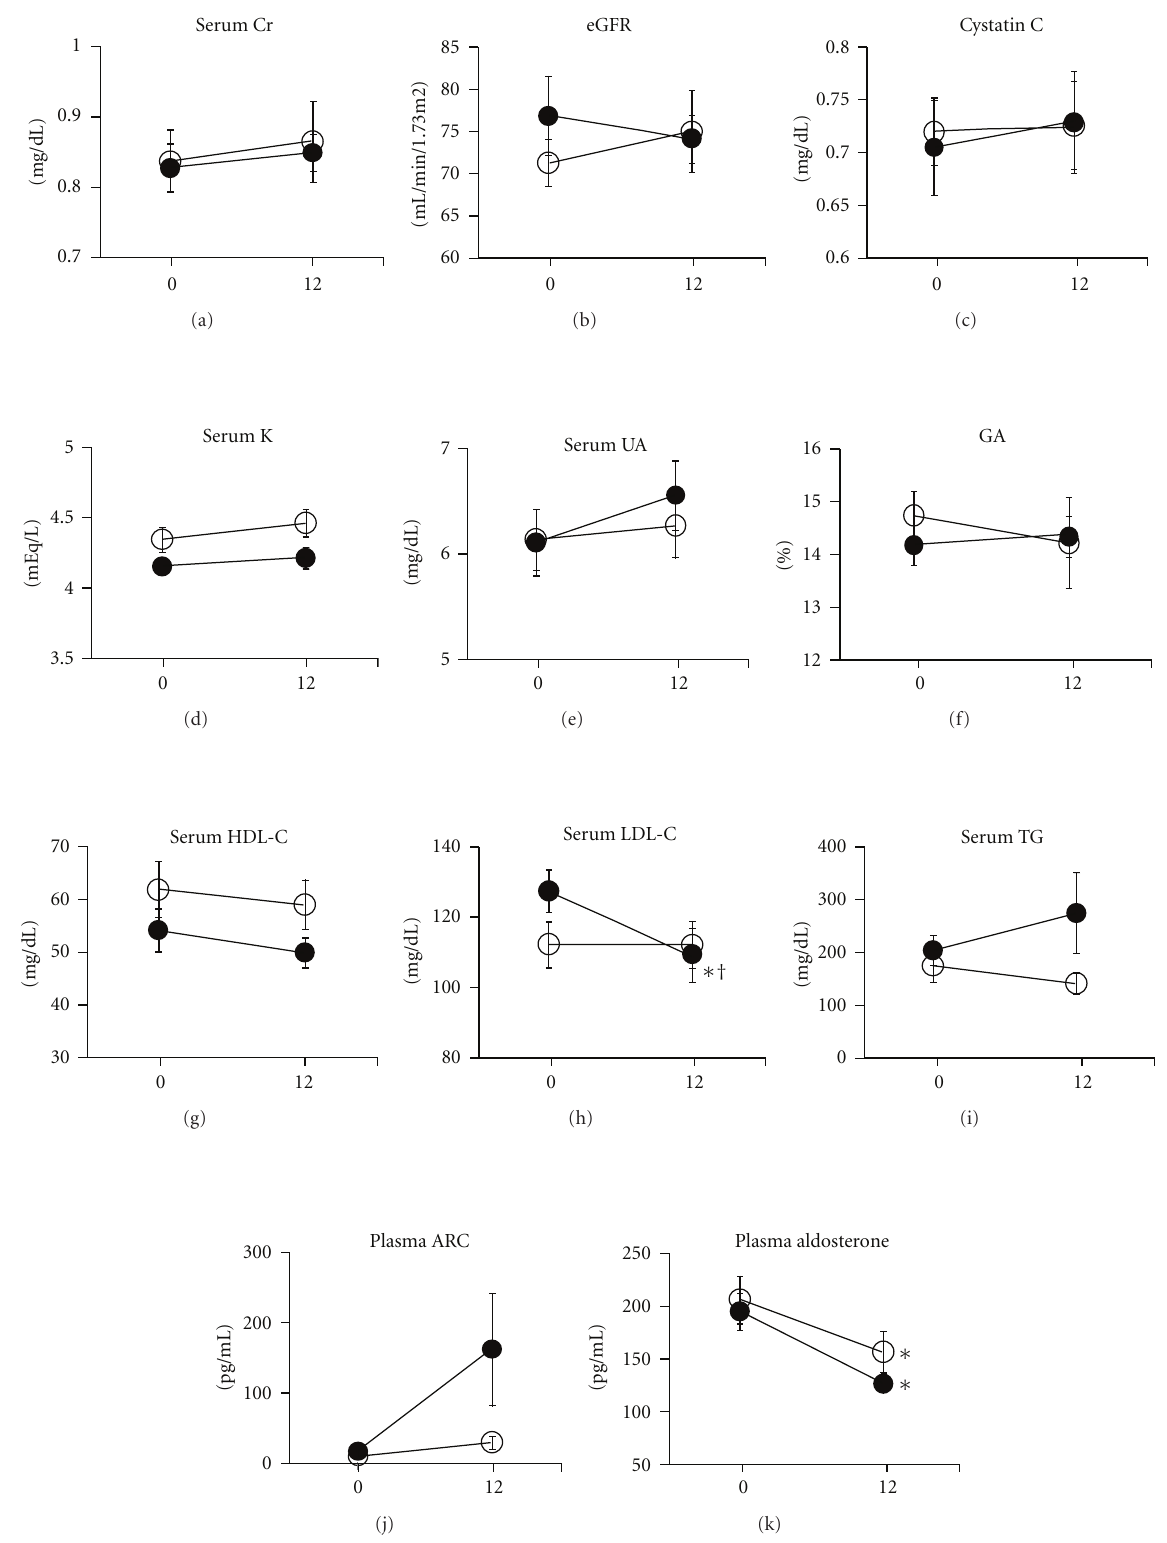
Figure 2: Serum creatinine (Cr), estimated glomerular filtration rate (eGFR), serum cystatin C, serum K, serum uric acid (UA), glycoalbumin (GA), serum high-density lipoprotein cholesterol (HDL), serum low-density lipoprotein cholesterol (LDL-C), serum triglyceride (TG), plasma active renin concentration (ARC), and plasma aldosterone at baseline and after 12 months of treatment with olmesartan monotherapy (open circles) or combination therapy with olmesartan and azelnidipine (closed circles). ∗ P < . 05 versus the baseline value, † P < . 05 versus the olmesartan